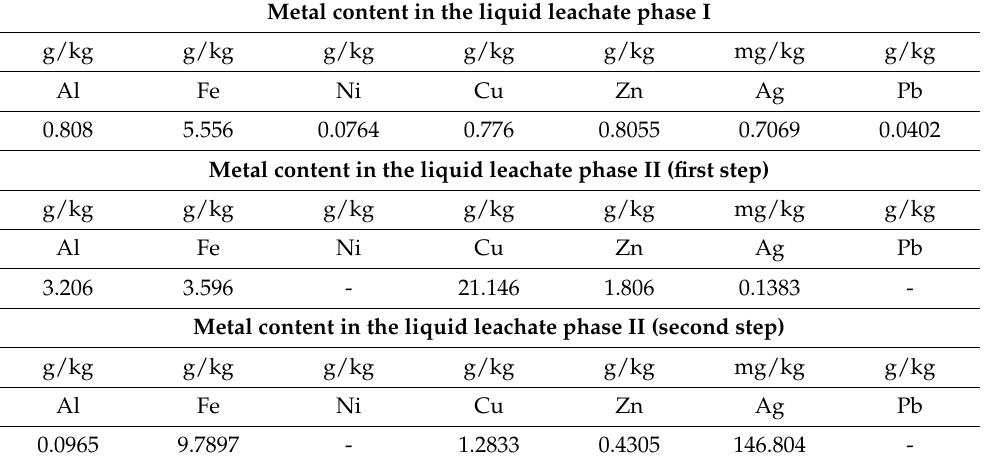
Table 4. Metal content in the liquid phases after alkalization of the post-leaching solutions to pH = 3 (ICP-OES